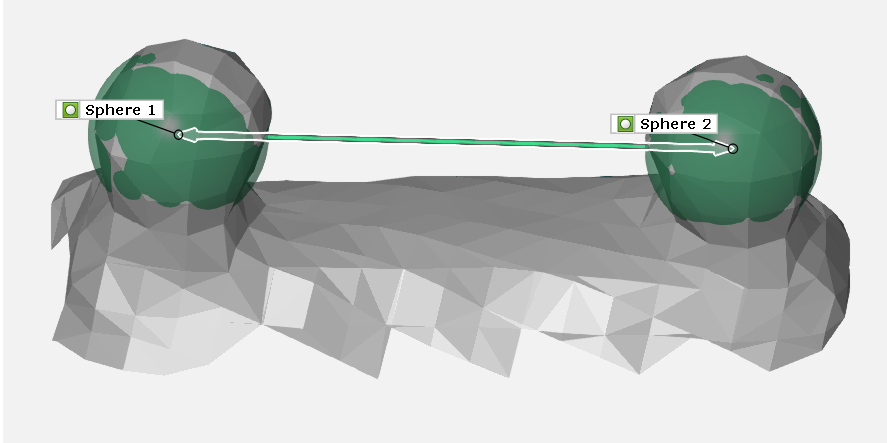
Figure 4. Measurements with calibration balls using GOM